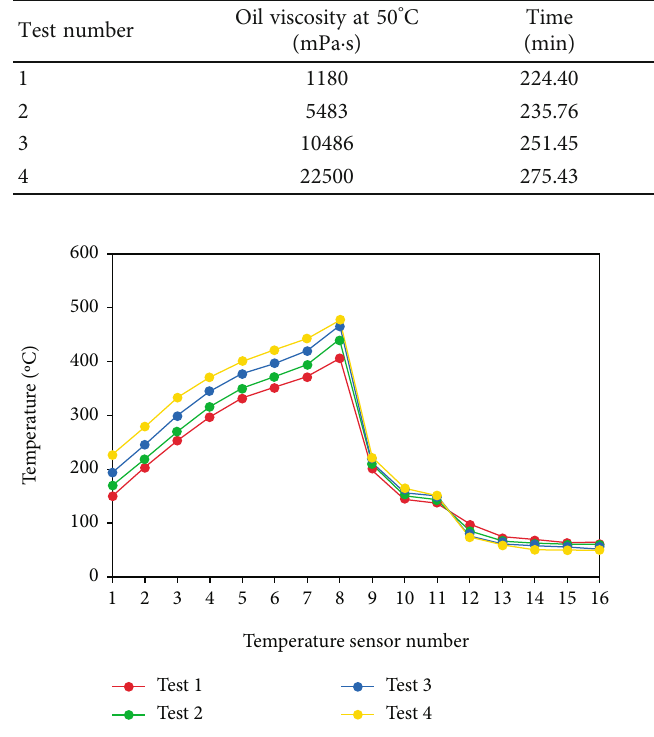
Figure 3: Temperature distribution curves when sensor 8 reached the peak.